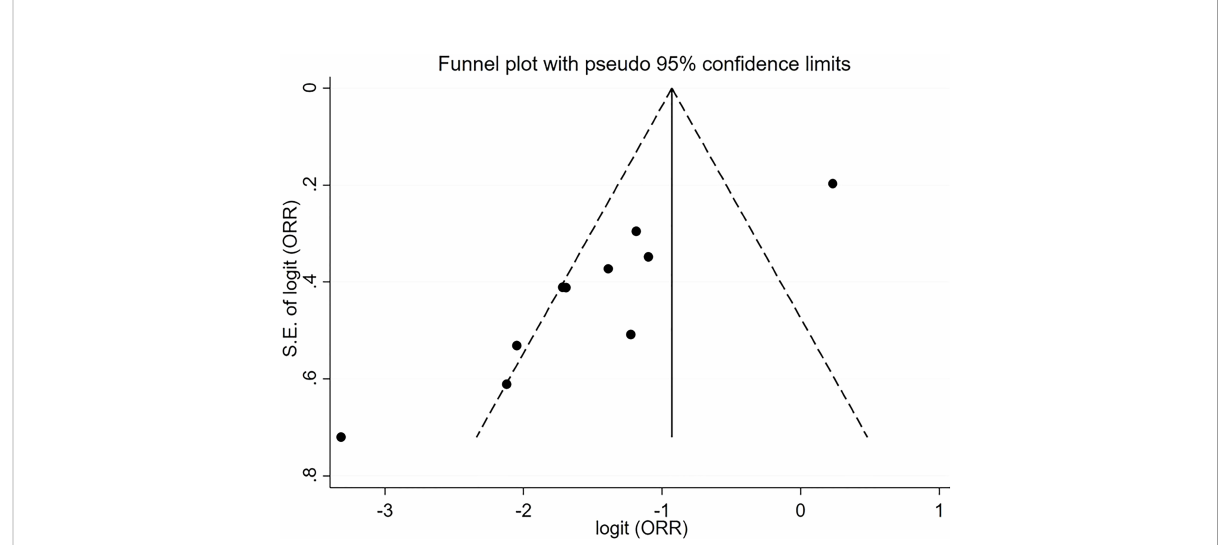
FIGURE 5 Funnel plot with pseudo 95% con fi dence limits for the estimation of the publication bias for the objective response rate (ORR) proportion with the logit